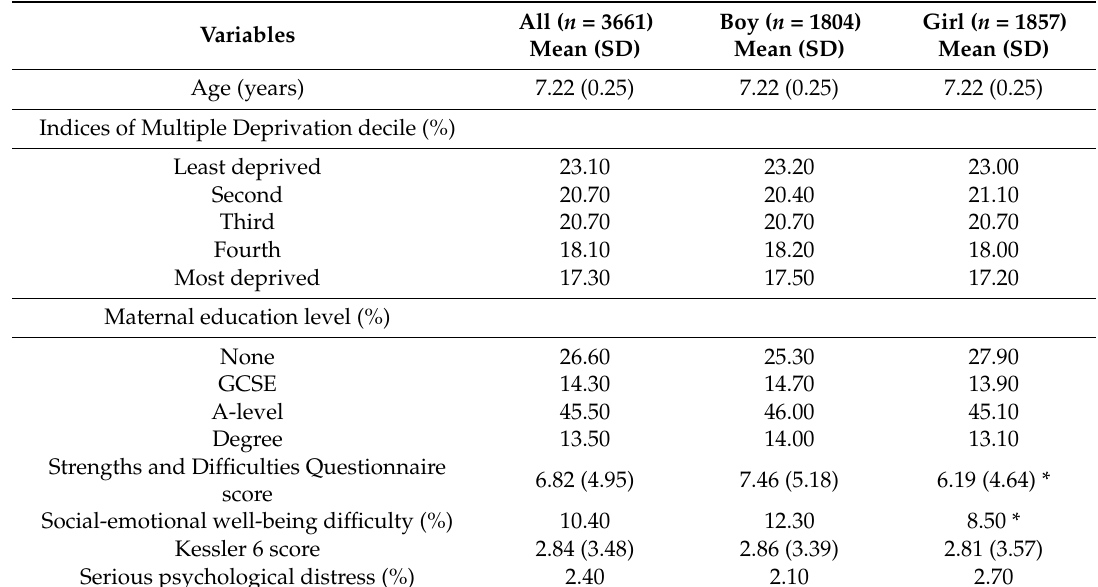
Table 1. Descriptive characteristics of full sample and gender